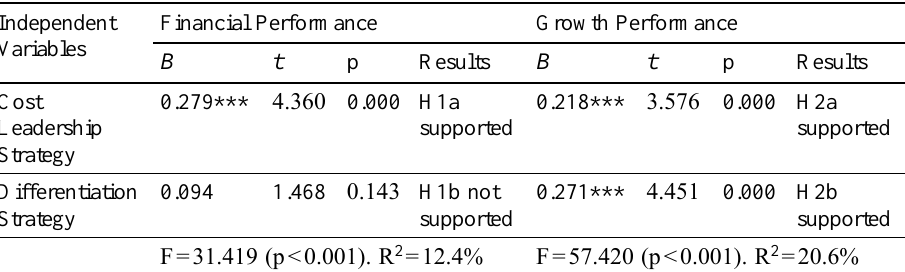
Table 5. The regression results among GSs and business performance